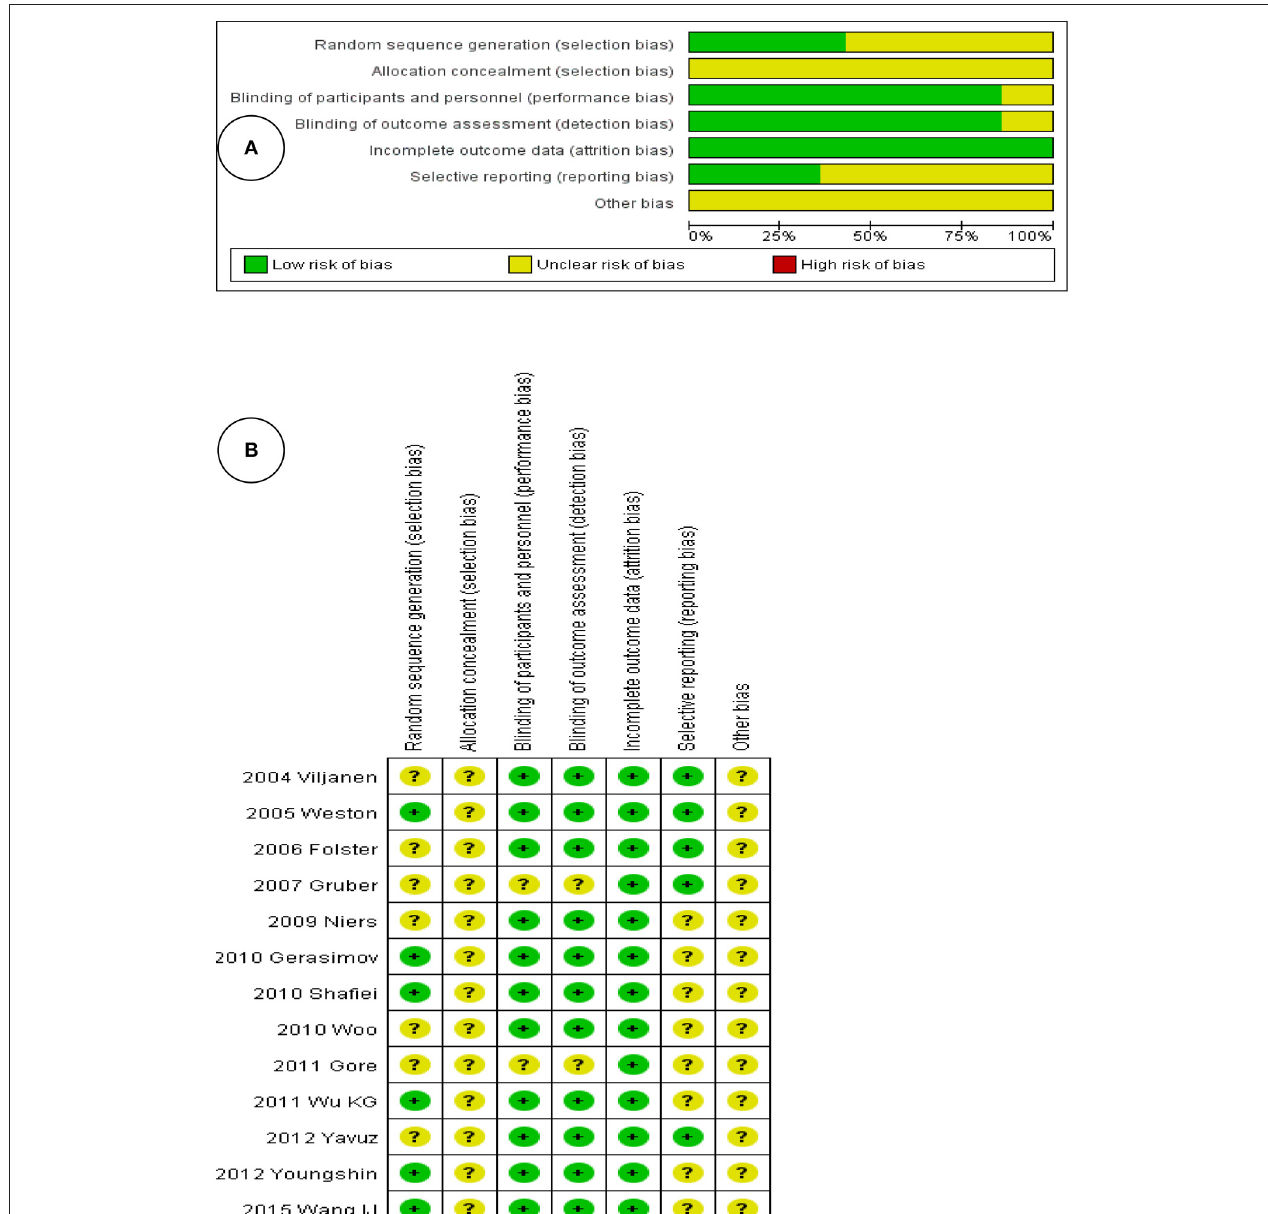
FIGURE 2 | (A) Risk of bias graph, with each risk of bias item presented as a percentage across all included studies. (B) Risk of bias summary, with each risk of bias item for each included study.